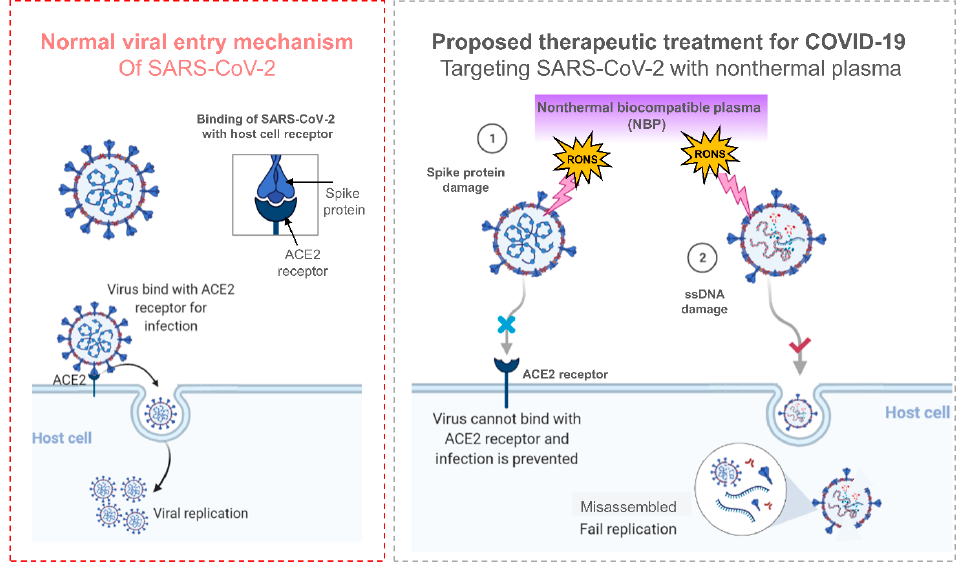
Figure 3. The mechanism of normal viral entry of SARS-CoV-2 to a host cell and the concept of its inactivation by utilizing NBP. Various RONs produced by NBP bind directly to the surface of virus particles to capture hydrogen atoms/ions and cause damage to the membrane proteins of the virus. It refuses to let the virus enter the lung cells caused by spike proteins bound to membranes, which do not bind properly to ACE-2 receptors. On top of that, the capsid proteins that protect RNA are decomposed and the molecular binding of RNA is broken, and even if the virus penetrates through the alveolar plasma membrane, contact viral components are not synthesized in lung cells due to genetic information damage. NBP is possible with new treatments against SARS-CoV-2 infection by these two-way